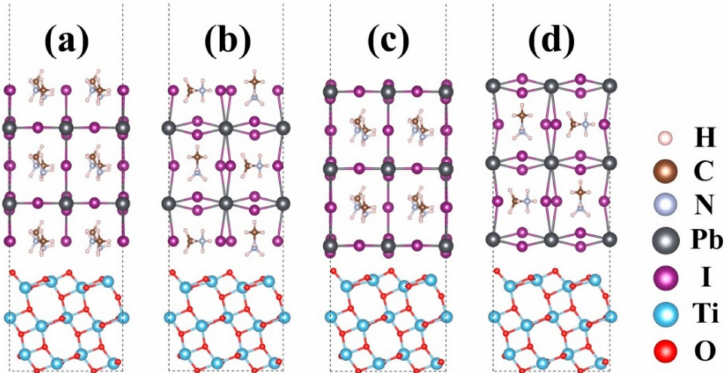
Figure 1. Schematic illustration of pristine CH 3 NH 3 PbI 3 / TiO 2 interface models: ( a ) CH 3 NH 3 I / TiO 2 ( b ) CH 3 NH 3 I / TiO 2 with rotation ( c ) PbI 2 / TiO 2 ( d ) PbI 2 / TiO 2 with